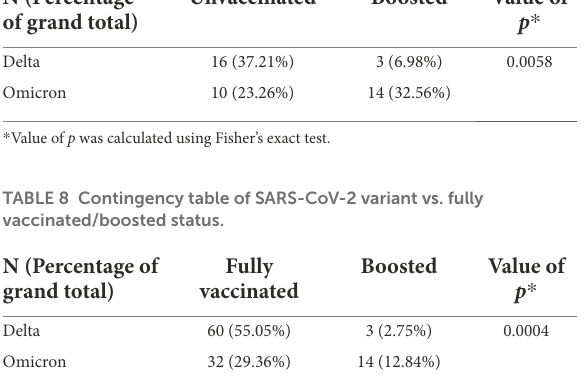
TABLE 7 Contingency table of SARS-CoV-2 variant vs. unvaccinated/ boosted status. N (Percentage of grand total)